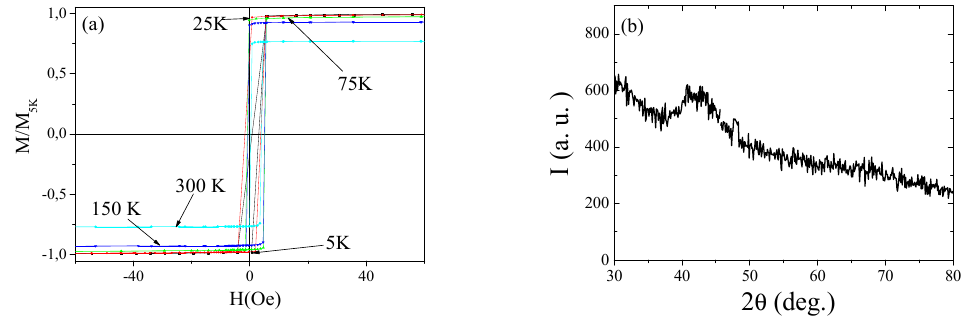
Figure 35. Hysteresis loops and XRD of as-prepared Fe 50 Pt 40 Si 10 microwire Reproduced from reference [48], Figure 2.